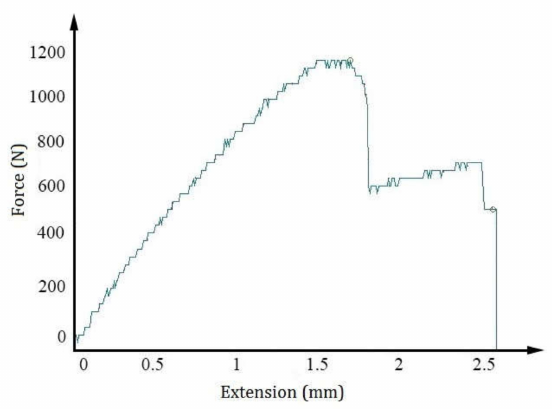
Figure 14. Extension-force diagram of the specimen for solution